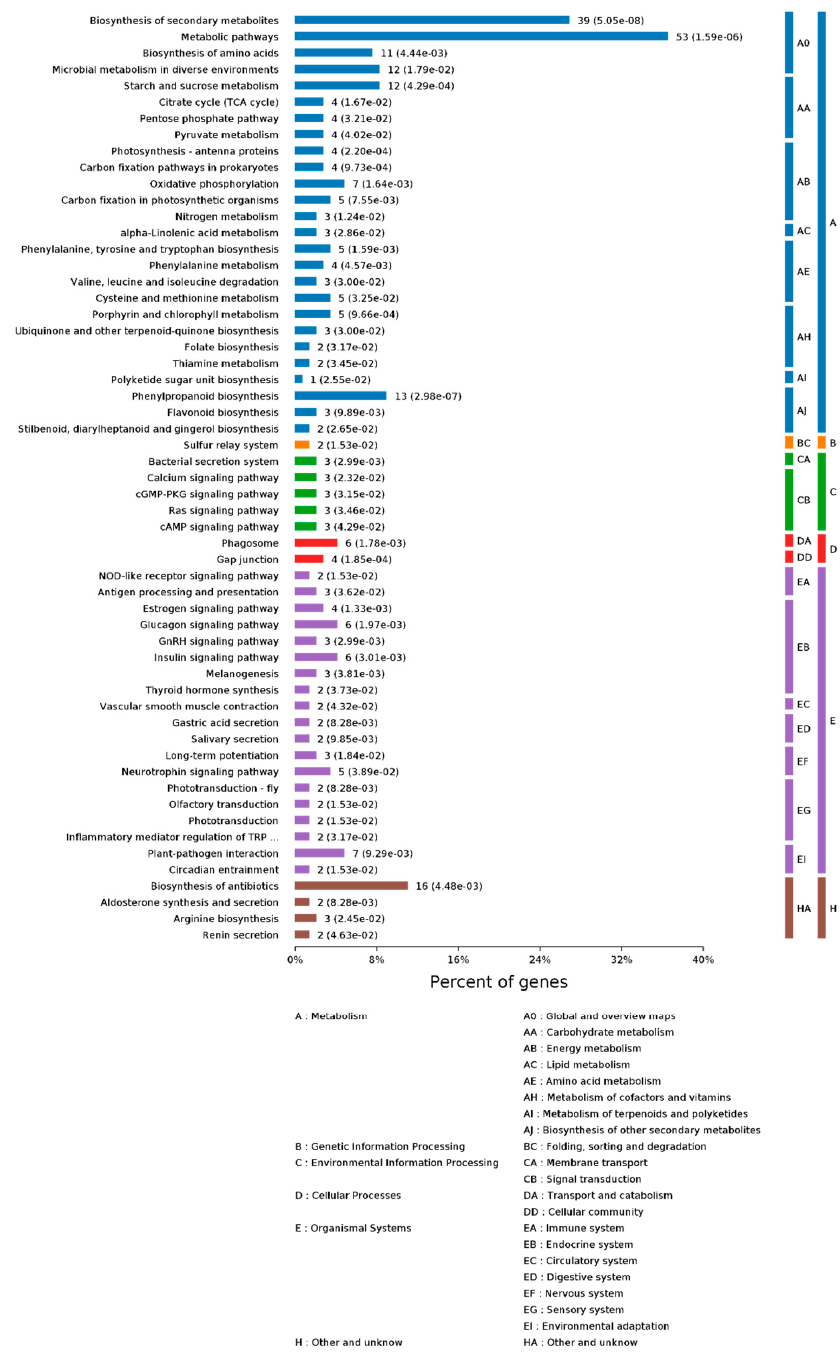
Figure 3. Kyoto Encyclopedia of Genes and Genomes (KEGG) pathways with significant protein enrichment between the B. pervariabilis × D. grandis induced by AP-toxin and the control group. ( A ) The top 10 KEGG signaling pathways with the most significant p values. Two limits of p values, 0.05 and 0.01, are indicated. ( B ) KEGG pathway classification indicates the signal pathways that are significantly enriched. Each bar is followed by the number of proteins and the corresponding p value. The